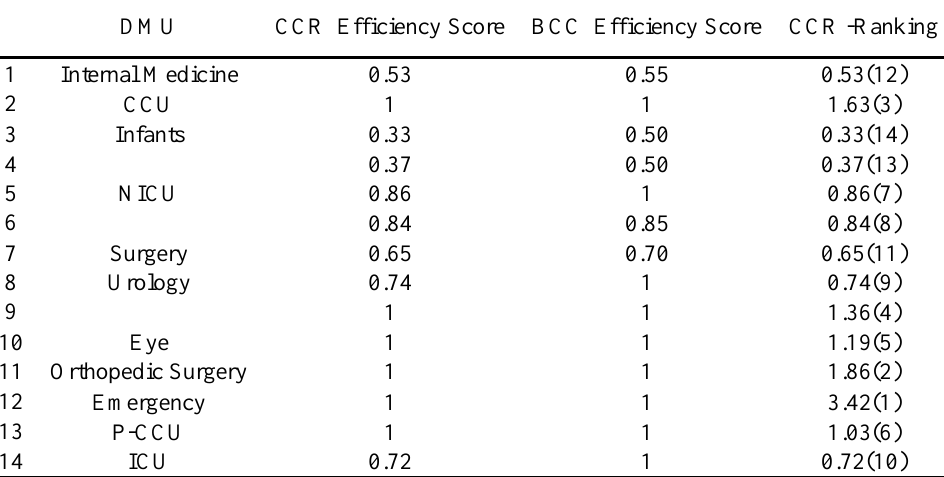
Table 4. Efficiency score and ranking in case study application in year 1390 .